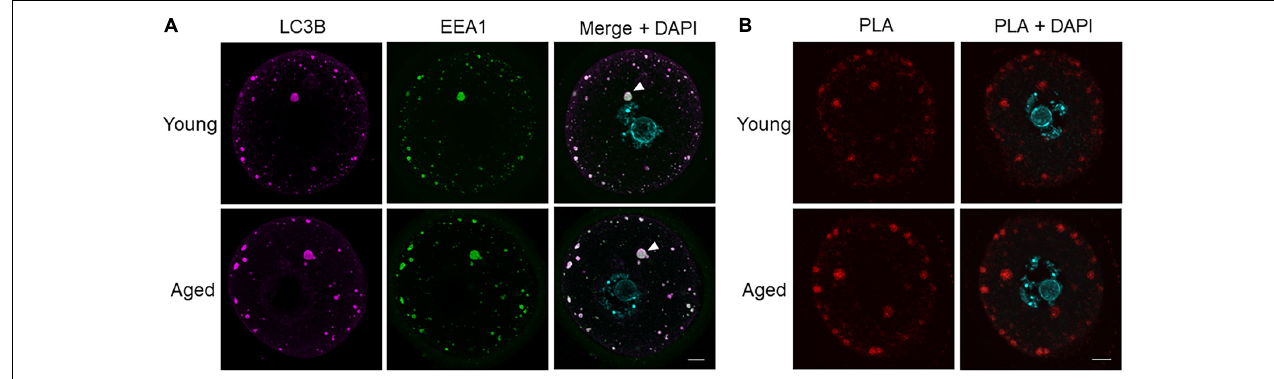
FIGURE 7 | Co-localization and proximity ligation assay for LC3B and EEA1 demonstrating presence of amphisomes in young and aged mouse oocytes. (A) Oocytes from young (4–6 weeks old) and aged (12–14 months old) mice were fixed prior to labeling with anti-LC3B antibodies (pink), anti-EEA1 antibodies (green), nuclear counterstaining with DAPI (cyan), confocal imaging (60 × objective), and puncta analysis. Representative images illustrate the punctate cytoplasmic co-localization of LC3B and EEA1 in young and aged oocytes where white arrow points to an example of large puncta. Scale bar = 10 µ m, N = 4. (B) Fixed young and aged oocytes underwent a proximity ligation assay for LC3B and EEA1 and were imaged through confocal microscopy (60 × objective). Representative images illustrate the characteristic punctate staining similar to that in (A) where red signal indicates proteins are within 40 nm.